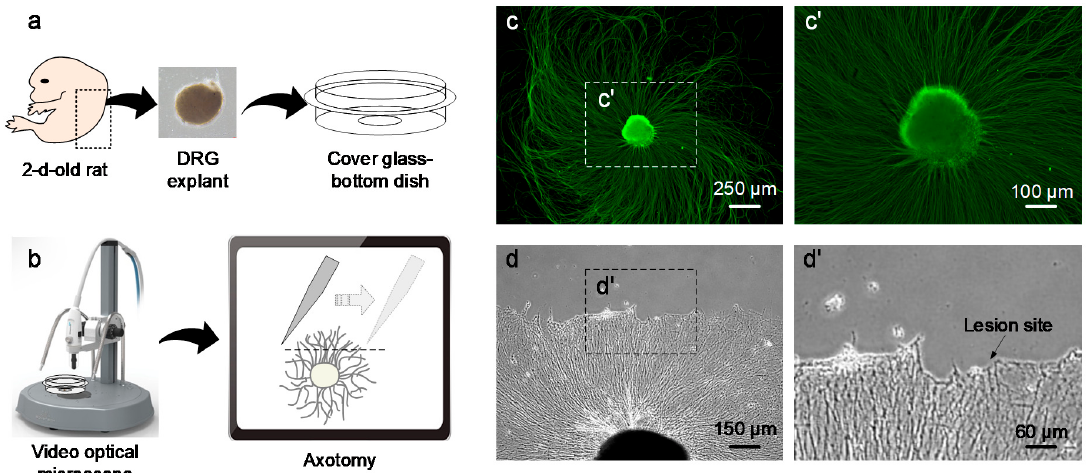
Figure 2. Representative images of cultured dorsal root ganglion (DRG) explants. ( a ) Schematic of the DRG explant culture. ( b ) Schematic of the axotomy method. ( c ) β -Tubulin fluorescence image of a DRG explant after five days of incubation. ( d ) Transacted neurites of DRG explants by axotomy. (c’, d’) Higher magnification images of the inserted boxes in (c) and (d).